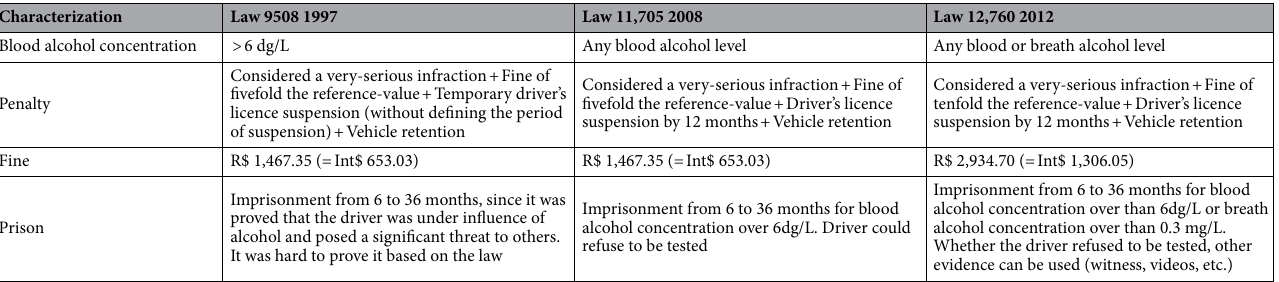
Table 1. Characteristics of the main regulation on drinking and driving law in Brazil. Source : Brazilian Traffic Code 26 . Note: We used the reference value currently in effect in Brazil (R$ 293.47) and the 2019 purchasing power parity—PPP—conversion factor of 2.247 from the World